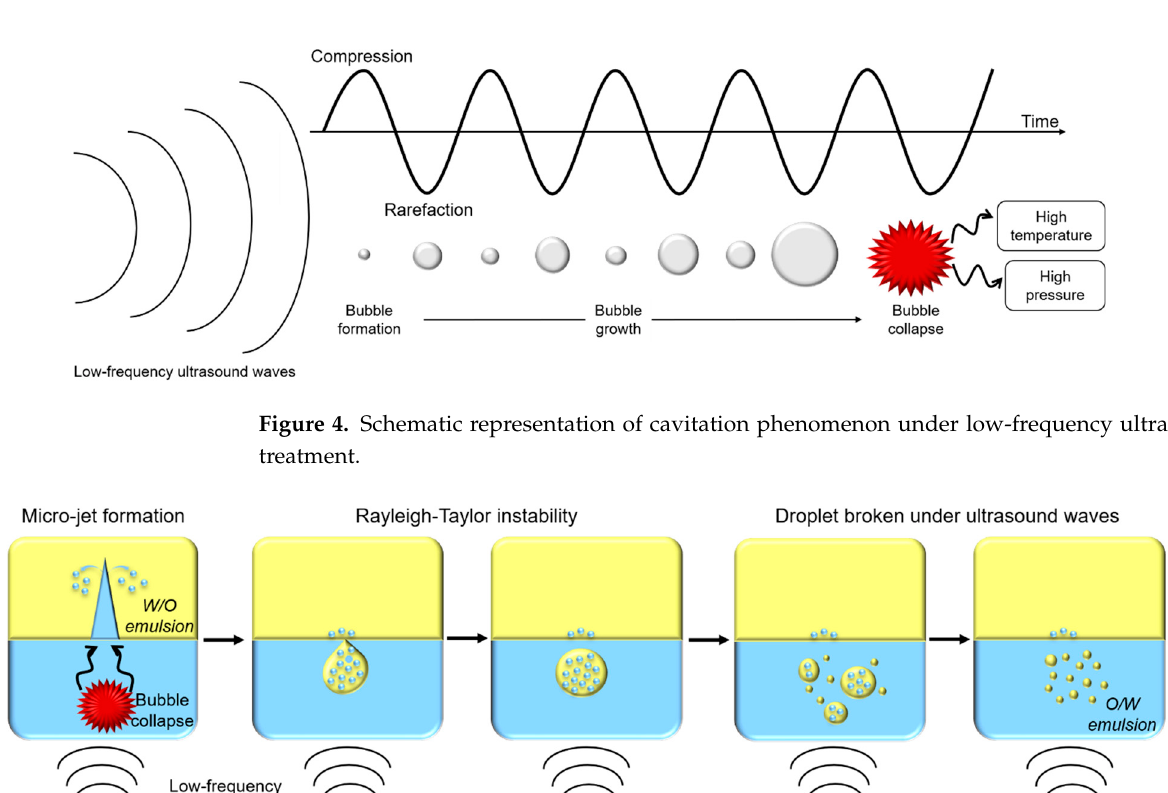
Figure 5. Schematic representation of oil ‐ in ‐ water (O/W) emulsion formation by low ‐ frequency ultrasounds.